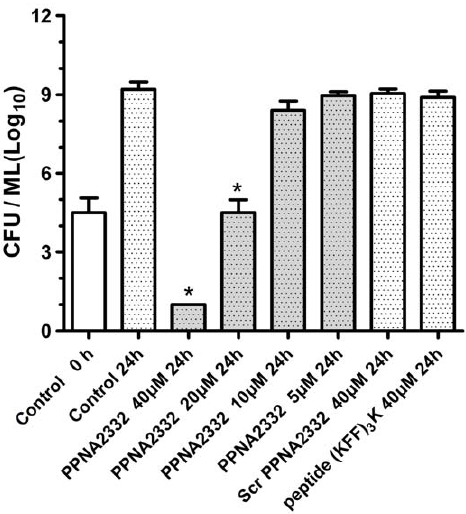
Figure 2. Effects of anti- rpoD PPNA2332 on the growth of MRSA/VISA Mu50 in pure culture. Anti- rpoD PPNA2332 was added to cell cultures containing 1.0 6 10 5 CFU/mL MRSA/VISA Mu50 to a final concentration of 6.25, 12.5, or 25 M. Additional cell cultures were treated with free MH broth, scrambled PPNA2332 (final concentration of 40 m M), and peptide (KFF) 3 K (final concentration of 40 m M) in a volume equal to that of the PPNA2332 preparation as controls. The growth of different groups of MRSA/VISA Mu50 cells was monitored by using OD measurements. The data are shown as means for 2 samples from 2 independent tests.